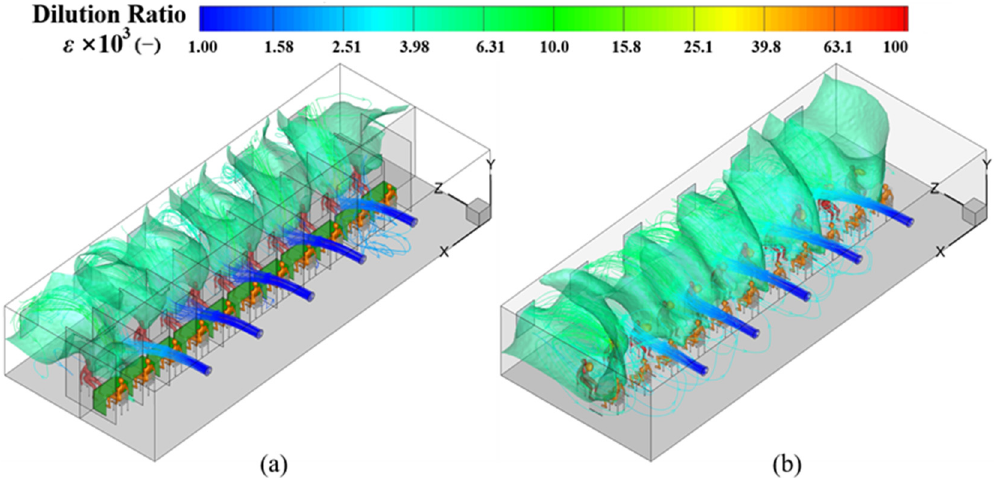
Figure 16. The streamline originating from the supply opening is colored by the dilution ratio, and the iso-surface with a dilution ratio of 5 × 10 − 3 : ( a ) before the partition was installed; ( b ) after the partition was installed.